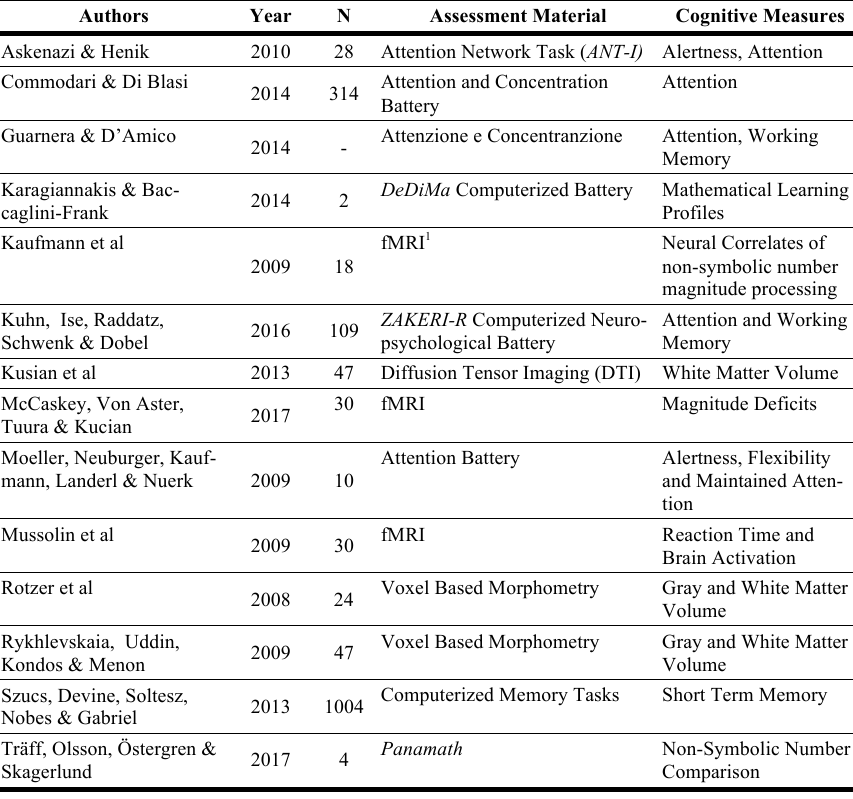
Table 1. Computerized neuropsychological assessment material and neuro-imaging techniques used to identify the cognitive profile of children with Specific Learning Disorder in